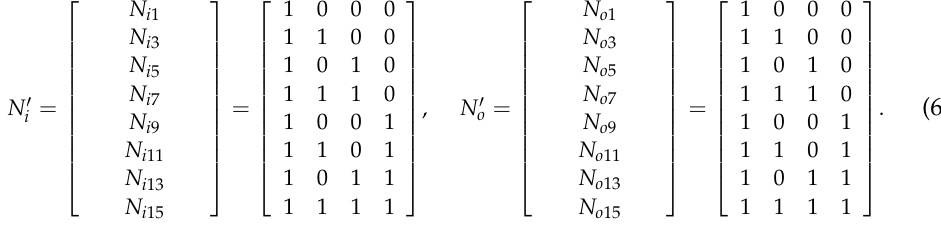
Figure 5 shows the characteristic curves of DHT pressure, flow, and gear–pump/mo- tor units’ rotational speed in the eight preceding power on/off logic combination states.